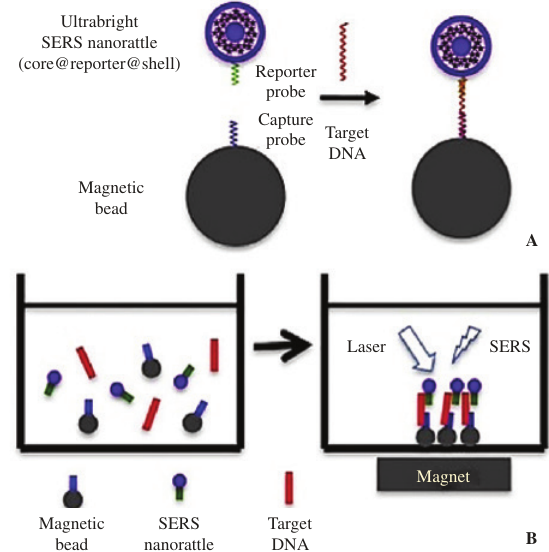
Figure 5: (A) The nanorattle-based DNA detection method using sandwich hybridization of (1) magnetic bead that are loaded with capture probes, (2) target sequence, and (3) ultrabright SERS nanorattles that are loaded with reporter probes. (B) A magnet is applied to concentrate the hybridization sandwiches at a detection spot for SERS measurements. Reprinted with permission from [27].